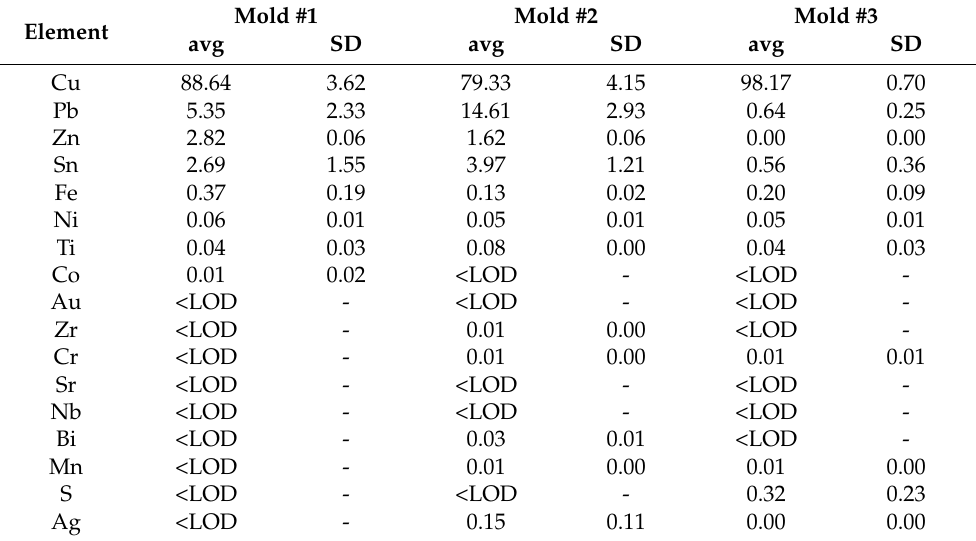
Table 1. XRF analysis of alloy samples from the examined mold samples (avg—average; SD— standard